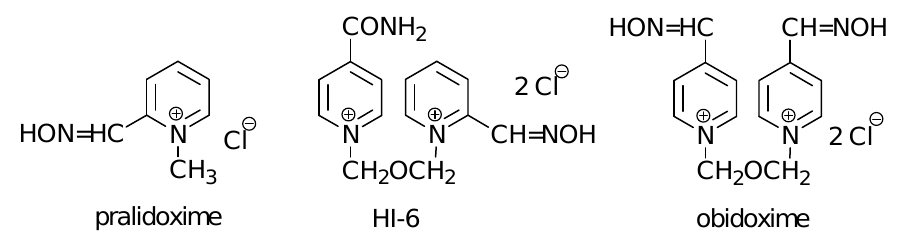
Figure 1. Reactivators of